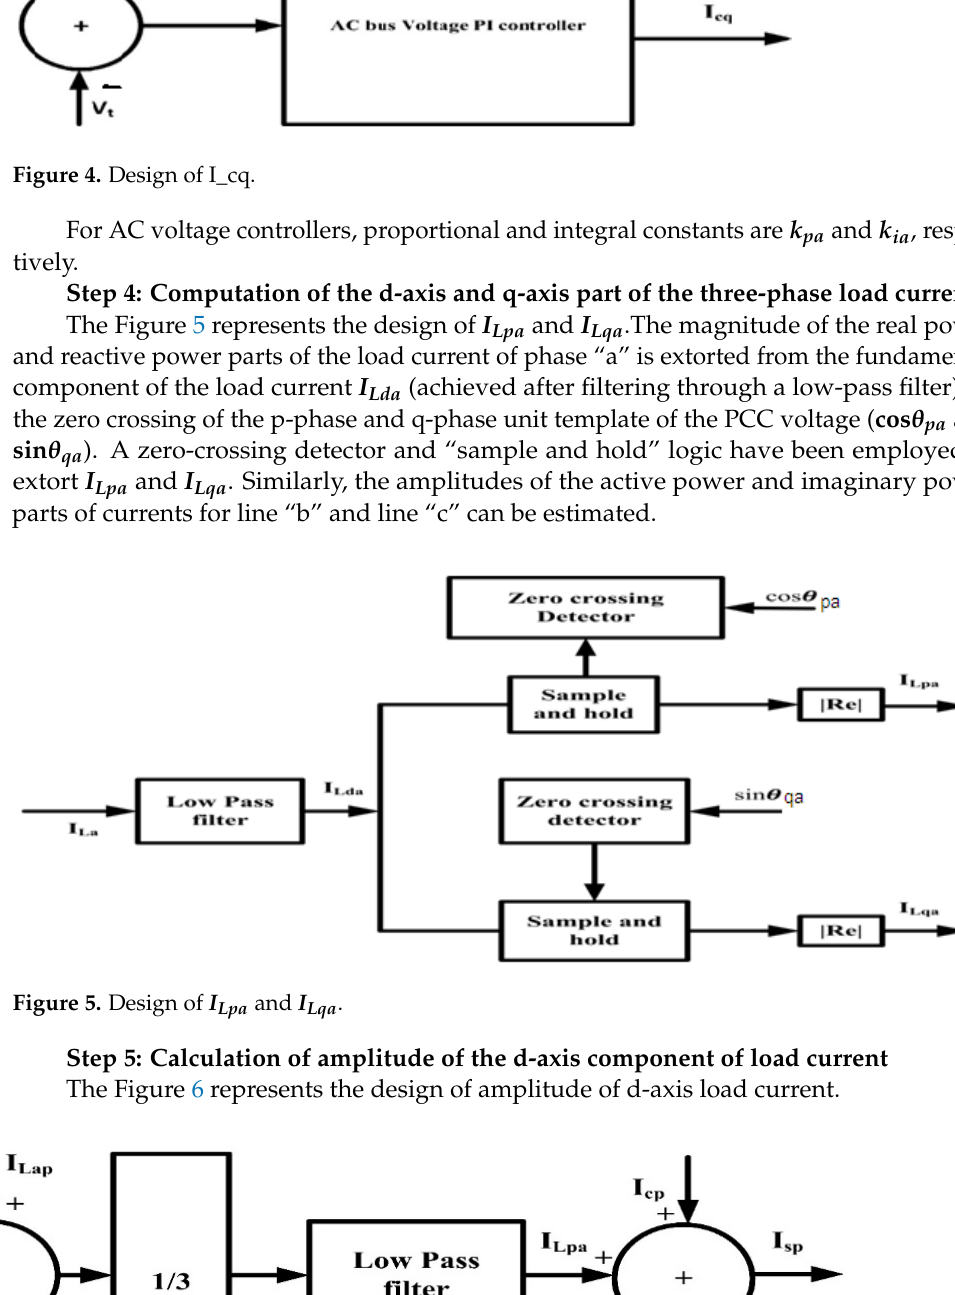
The Figure 4 represents the design of I_cp. In the DC bus, proportional and integral constants are k pd and k id , respectively. Step 3: Calculation of I_cq, which is the part of the q-axis component